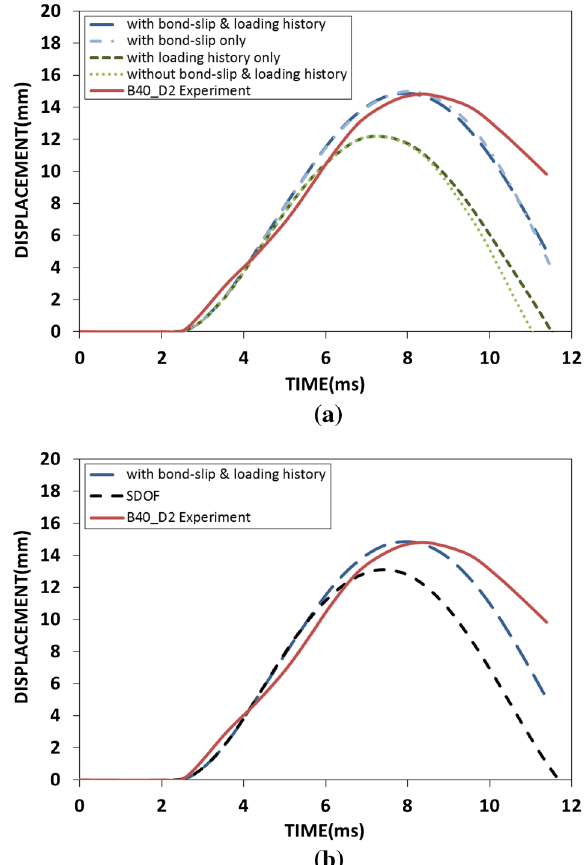
Fig. 8 Mid-span deflection with time for B40_D2. a Compar- ison with experiment and b comparison with SDOF